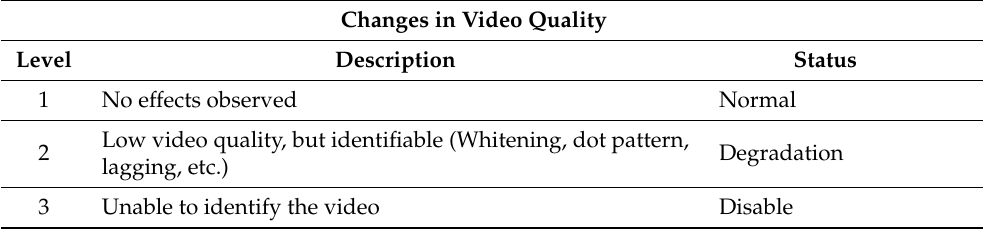
Table 5. Criteria for the changes in video quality by external interference signals.